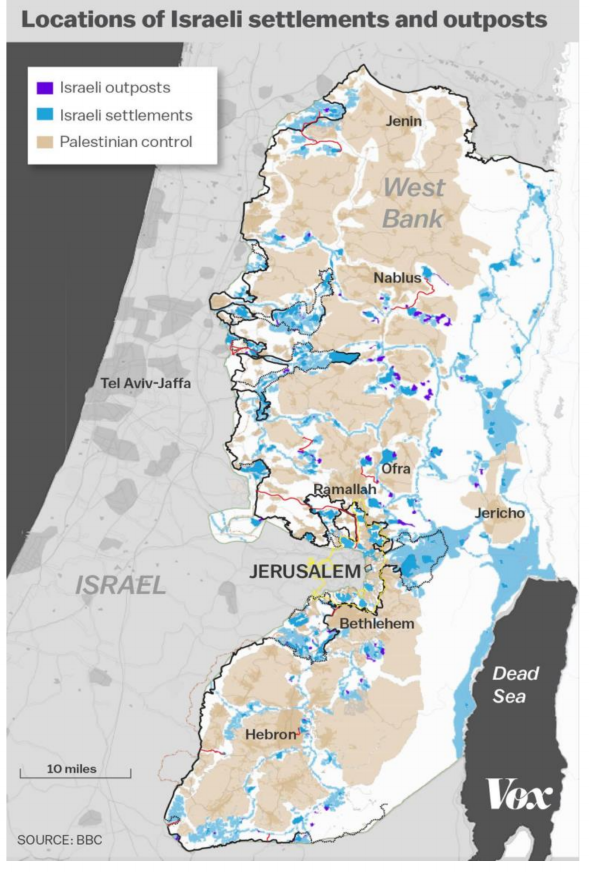
Figure 4. Israeli settlements in West Bank, Palestine